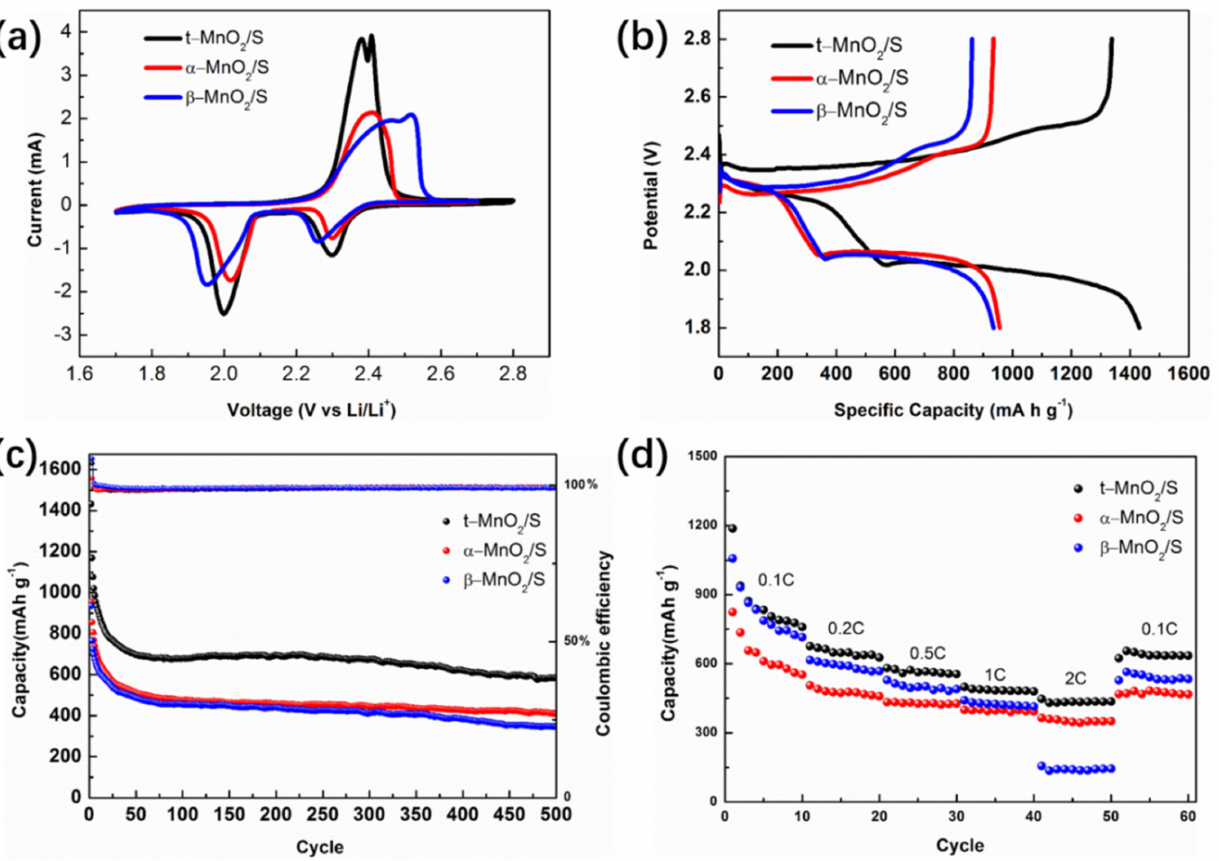
Figure 5. Electrochemical performance of Li-S battery: ( a ) CV profiles; ( b ) the first charge-discharge curves; ( c ) long cycle performance; and ( d ) rate